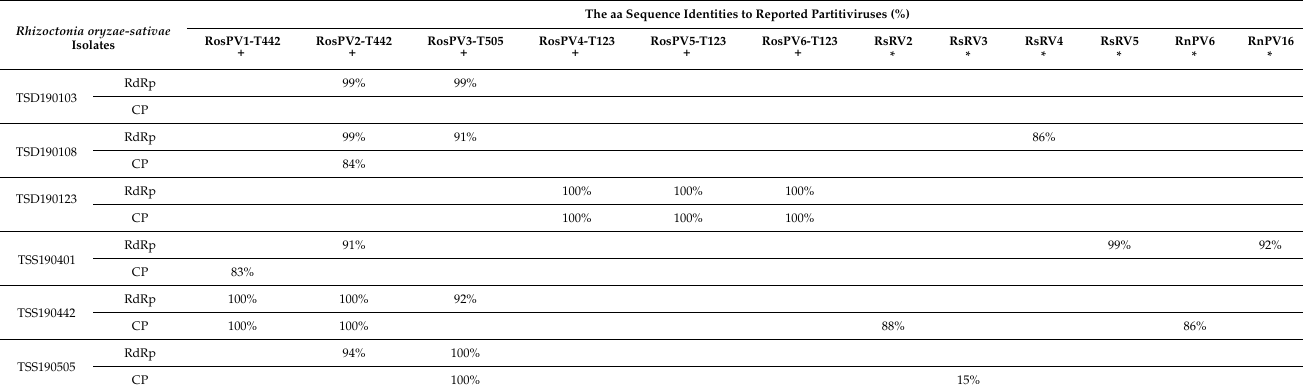
Figure 4. Widespread infection of partitiviruses among R. oryzae-sativae isolates. cDNAs synthesized from total RNA fractions were used as templates to detect the presence of the six partitiviruses, RosPV1 to RosPV6 (indicated on the right side of panels). Coinfection of more than two partitiviruses in a single isolate was observed but no single infection. M indicates a DNA size marker in the length of 1 kbp, and green letters above the panel indicate R. oryzae-sativae isolates. Asterisks represent positive control by which each partitivirus was detected from their original host. Table 2. Sequence identities of cDNA contigs to newly or previously reported partitiviruses’ protein (RdRp or CP) by